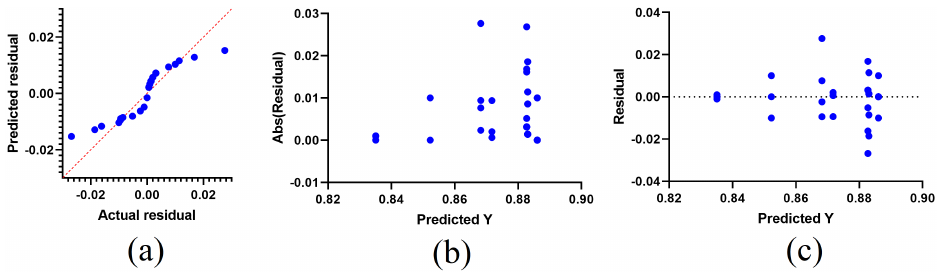
Figure 10. Analysis plots of the achieved results based on the proposed feature selection algorithm, bPSOBER. ( a ) QQ plot, ( b ) Homoscedasticity plot, ( c ) Residual plot.